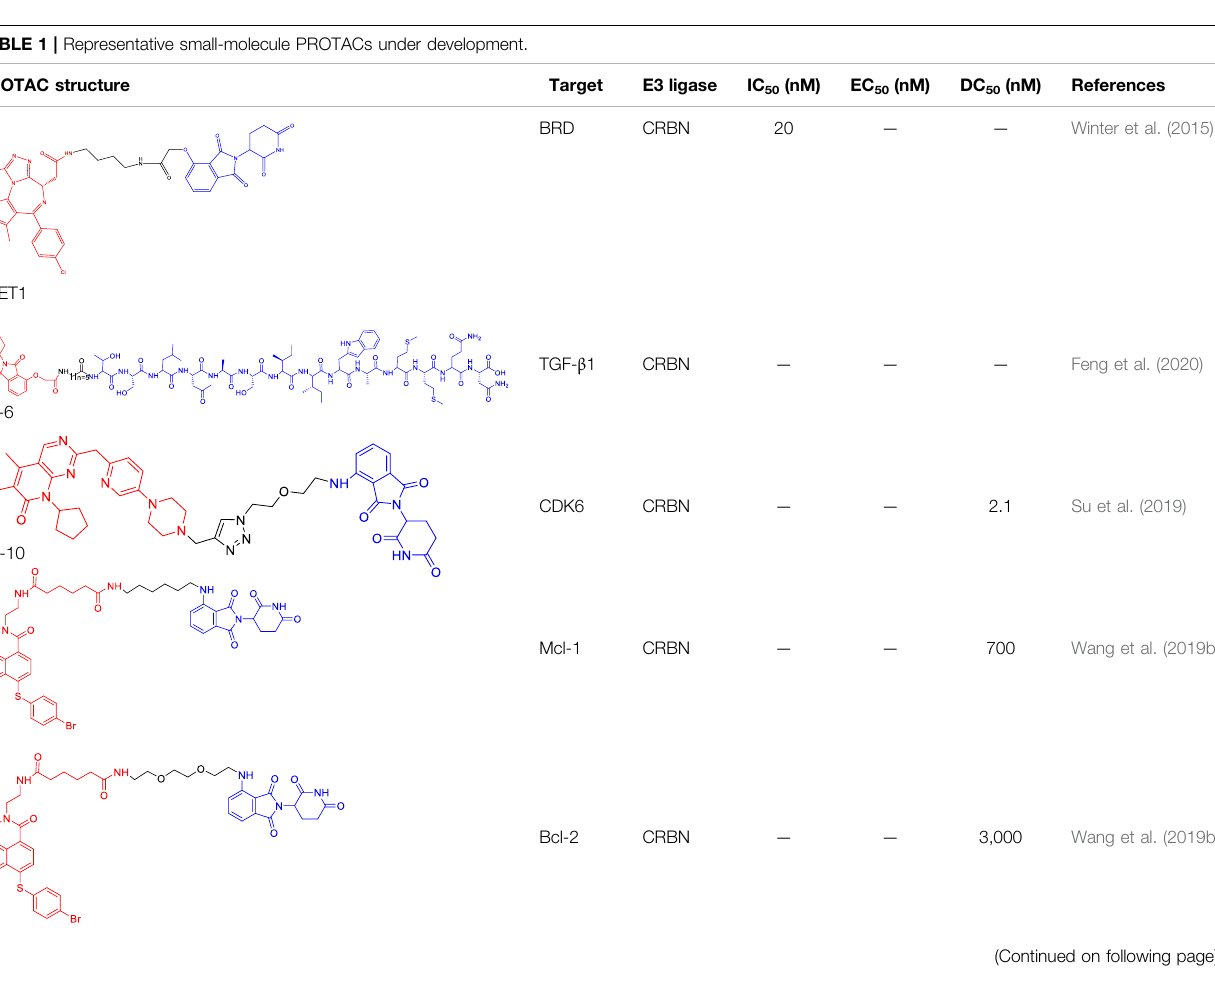
TABLE 1 | Representative small-molecule PROTACs under